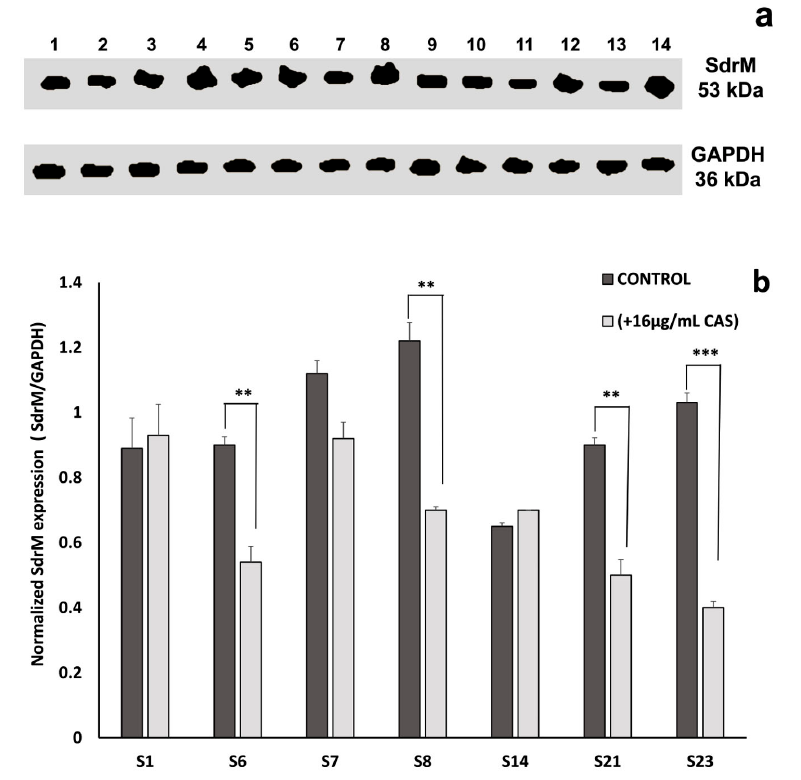
Fig. 7 . Effect of caspofungin on SdrM efflux pump protein (53 kDa) in 7 MRSA clinical isolates. (a) Western blot analysis for untreated samples (control), lanes: 2, 4, 6, 8, 10, 12, and 14 and in the presence of 16µg/ml caspofungin (treated), lanes: 1, 3, 5, 7, 9, 11, and 13 representing isolates S1, S6, S7, S8, S14, S21, and S23, respectively. (b) The corresponding SdrM protein expression values for isolates S1, S6, S7, S8, S14, S21, and S23 following calibration against GAPDH. All data are mean ± SD of triplicates. The error bars represent SDs. The p-values indicate significance where ** p<0.01 and ***